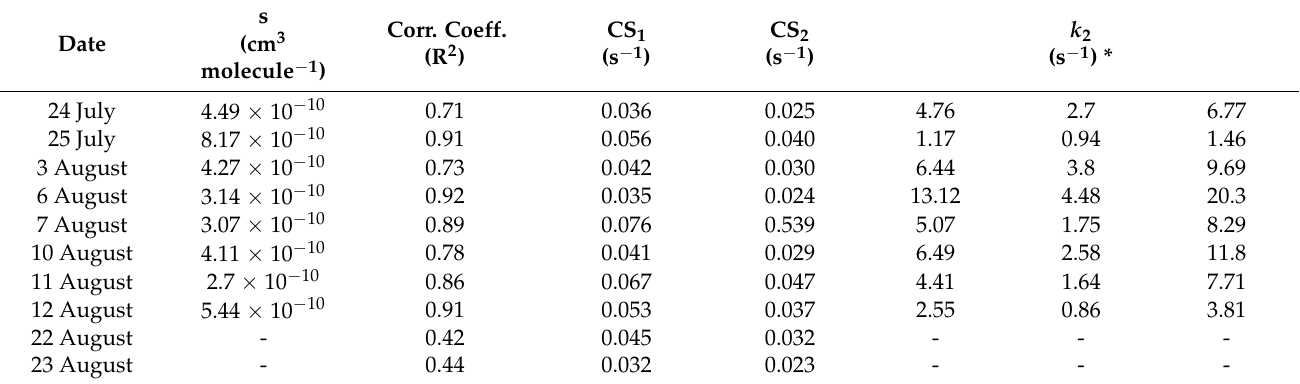
* The three columns for k 2 correspond to average, minimum, and maximum [ B ] used in calculating the evaporation rates of AB